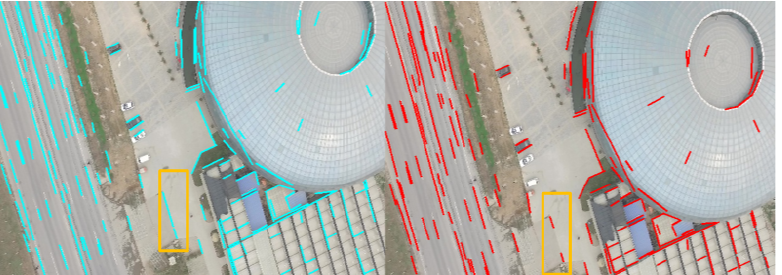
Figure 5. Illustration of the incomplete detection of line segments. The short lines with cyan and red color represent line segments in the two